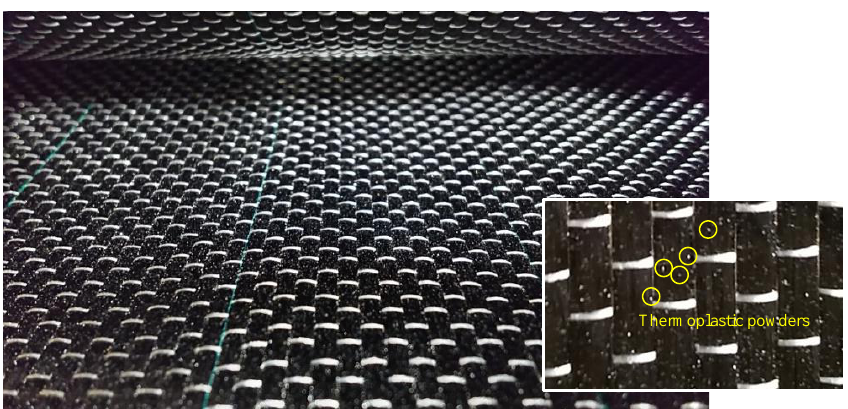
Figure 2. Pre-formable carbon fiber cloth.